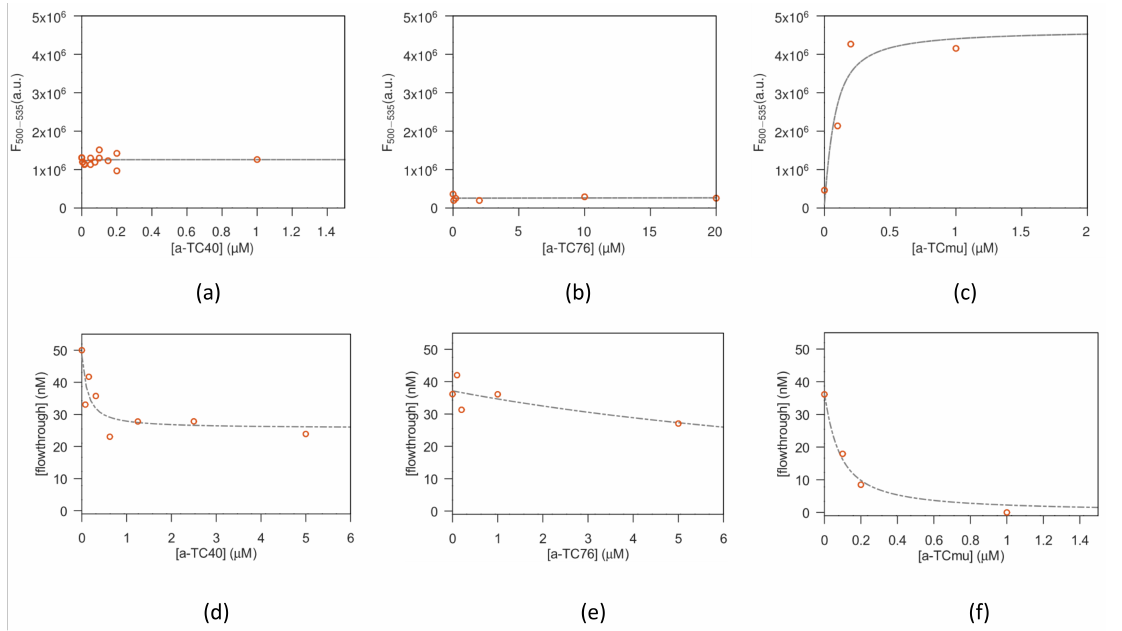
Figure 3. Binding tests of tetracycline and aptamers: circles (experimental data), dashed lines (fit). Fluorescence emission data for TC incubated with aptamer a-TC40 ( a ), a-TC76 ( b ) and for a-TCmu ( c ). Data obtained with a-TC8 are similar to ( b ). Data obtained with the filtration test for tetracycline and a-TC40 aptamer ( d ), a-TC76 aptamer ( e ) and a-TCmu aptamer ( f ).